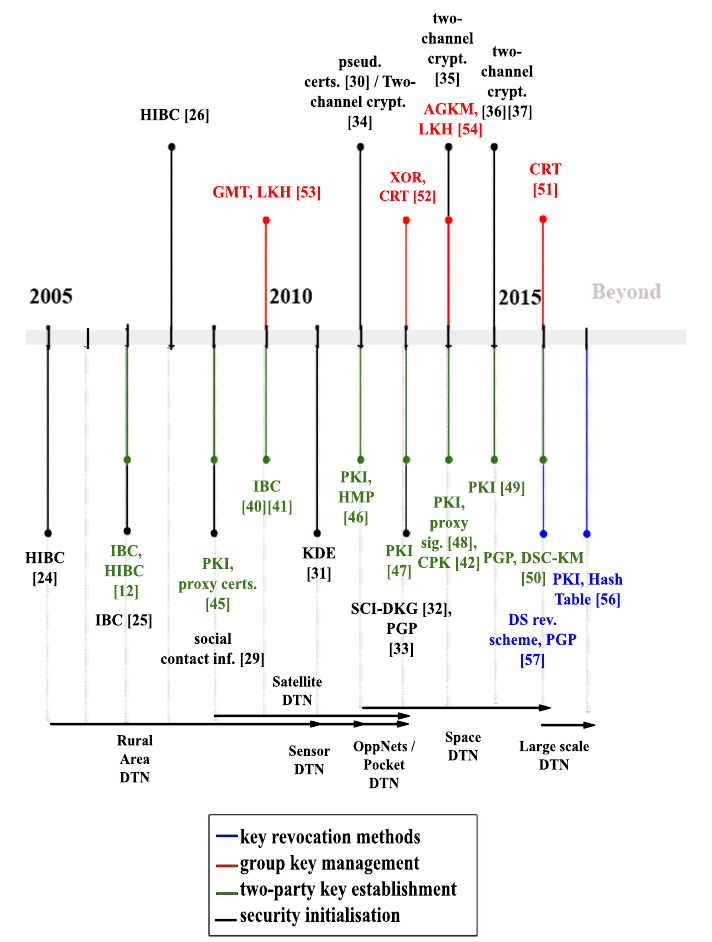
Figure 2. DTN key management